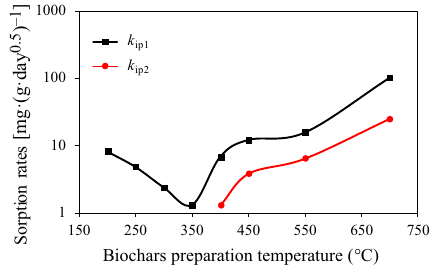
Fig. 2 Sorption rates of 1,3,5-trinitrobenzene on